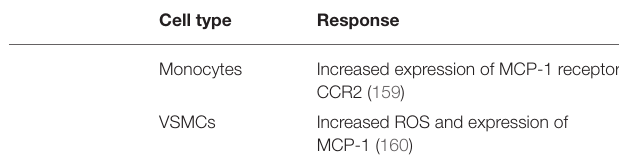
TABLE 2 | Cellular responses to selected modified